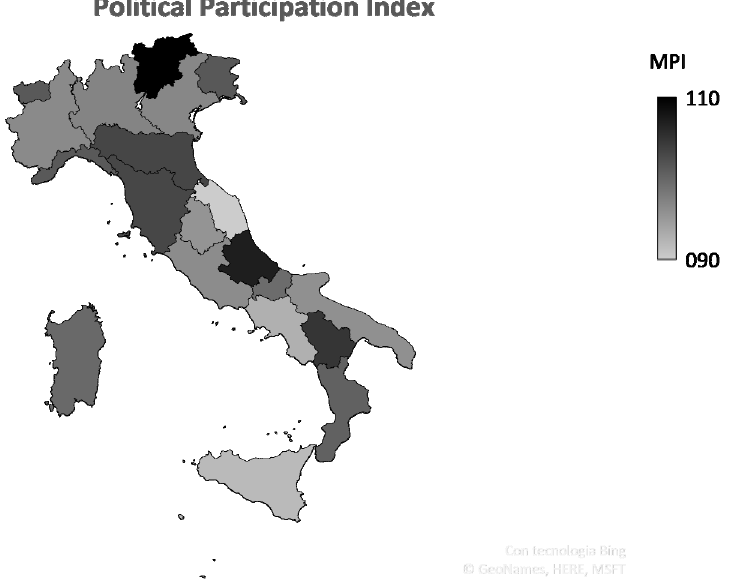
Figure 3. Cartogram of political participation index.